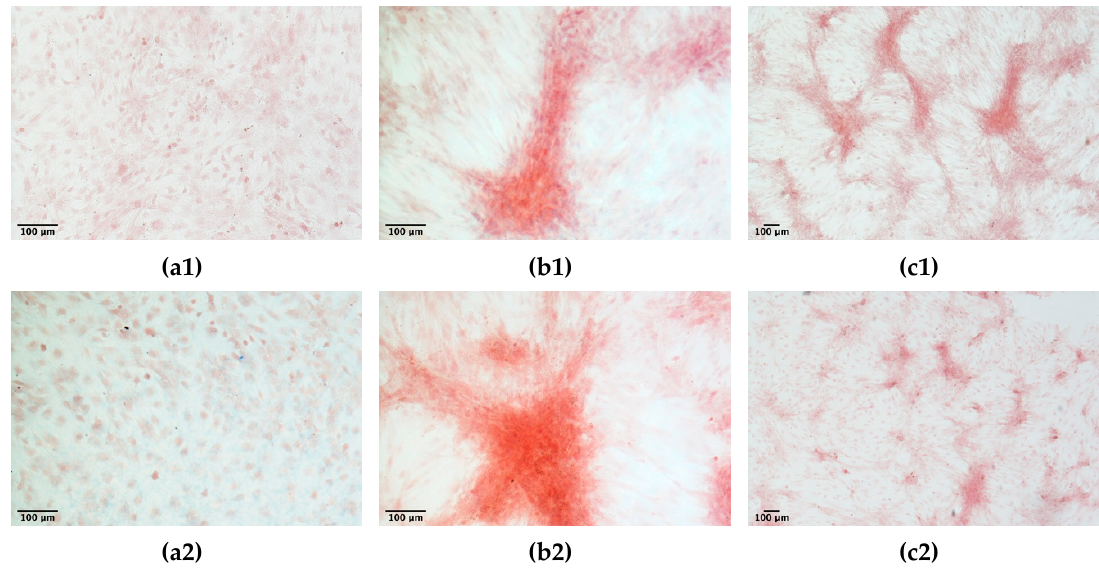
Figure 13. Osteogenic di ff erentiation of ADMSCs: ADMSCs expanded on plastic ( b1 , c1 ) or inside the 3D fibrin-based matrix ( b2 , c2 ) were positive to Alizarin Red staining after stimulation with osteogenic di ff erentiation medium. Control, unstimulated cells ( a1 , a2 ) were negative to staining.